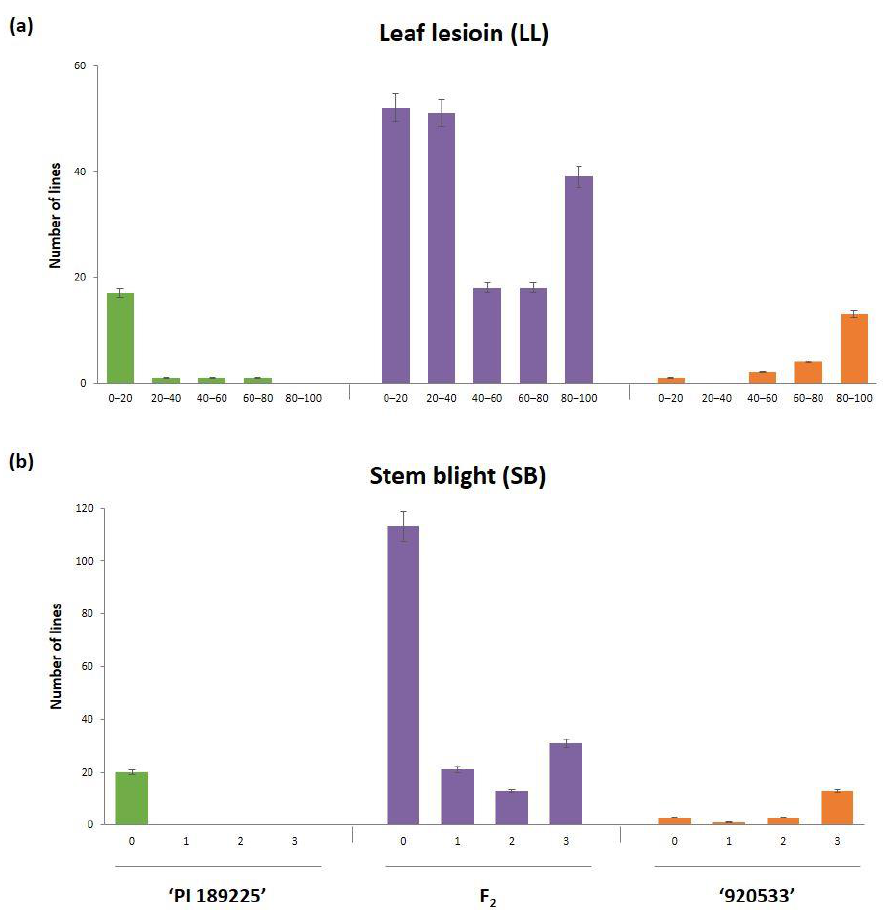
Figure 1. Frequency distribution of disease severity. ( a ) Leaf lesion (LL) and ( b ) stem blight (SB) among parental lines and F 2 population. Green, orange and purple bar indicates resistant parent ‘PI 189225’, susceptible parent ‘920533’, and an F 2 population obtained from a cross between ‘920533’ × ‘PI 189225’, respectively. Error bars indicates the standard error (SE).